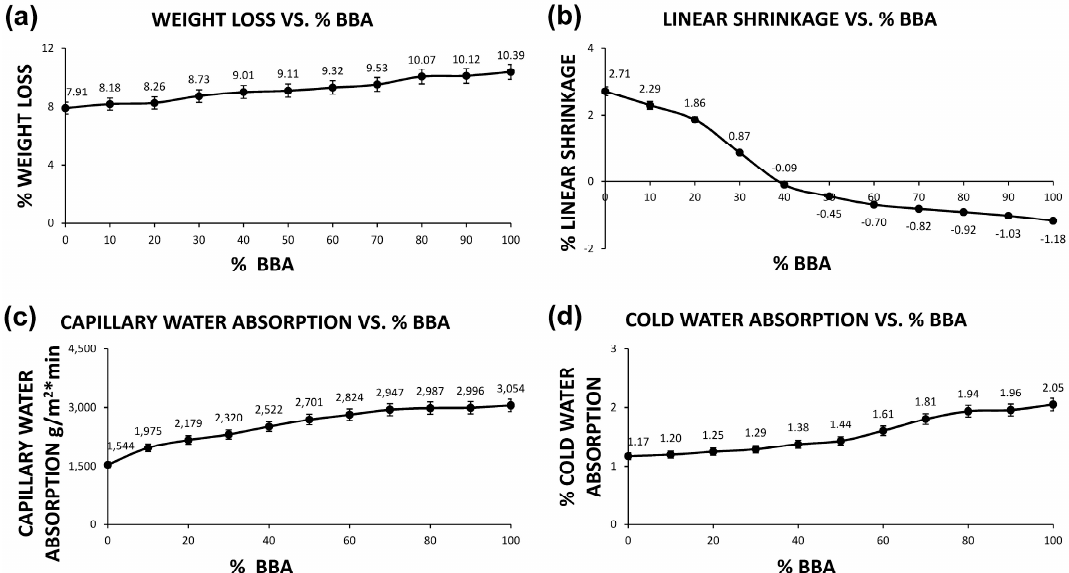
Figure 1. Graphs of the different physical properties of ceramics as a function of the percentage of biomass bottom ash: ( a ) weight loss, ( b ) linear shrinkage, ( c ) capillary water absorption and ( d ) cold water absorption.